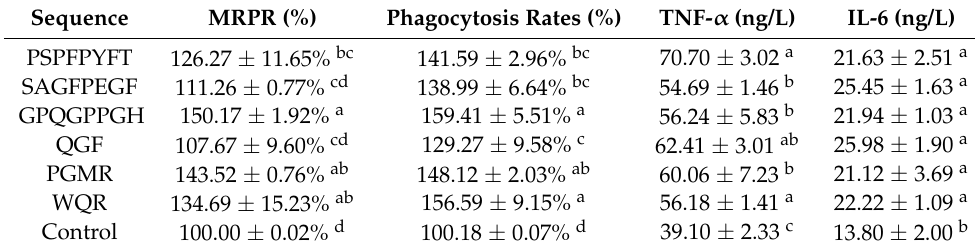
Table 2. Immunomodulatory activities of synthetic